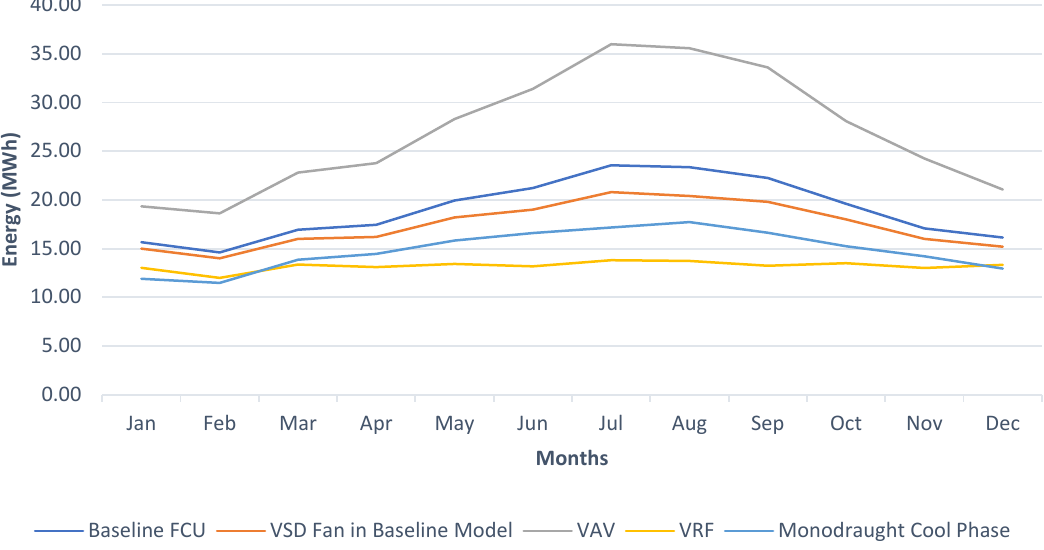
Figure 3. Trend in monthly energy consumption for different cooling systems.